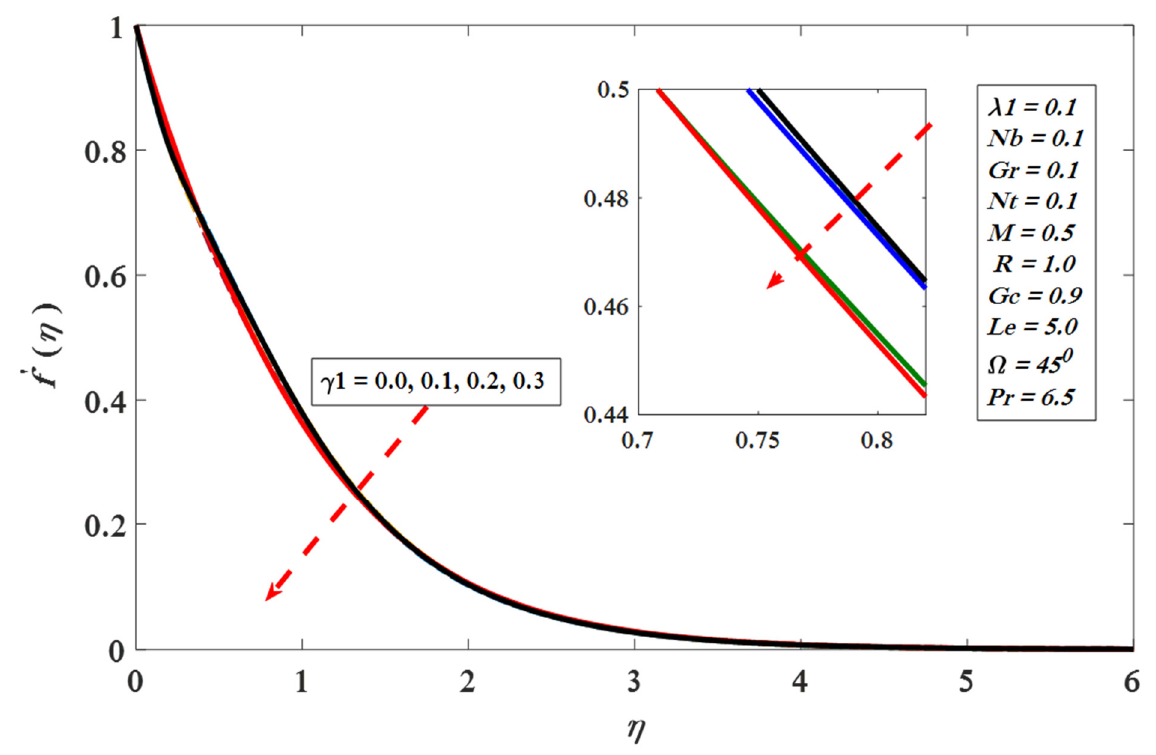
Figure 6. Velocity profile versus γ